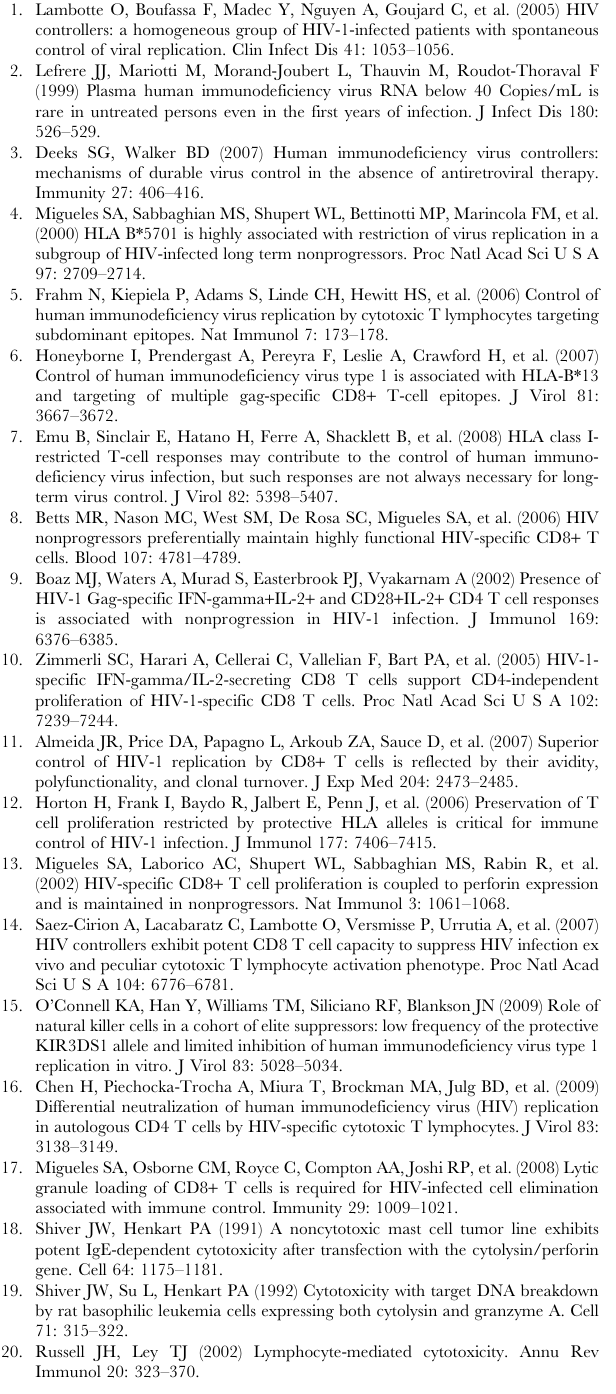
Table S1 Complete study cohort with relevant clinical